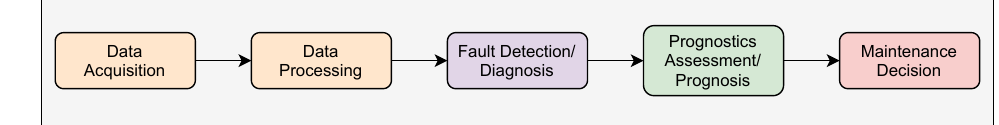
Figure 3. Framework of prognostic techniques applied to critical components of WTs